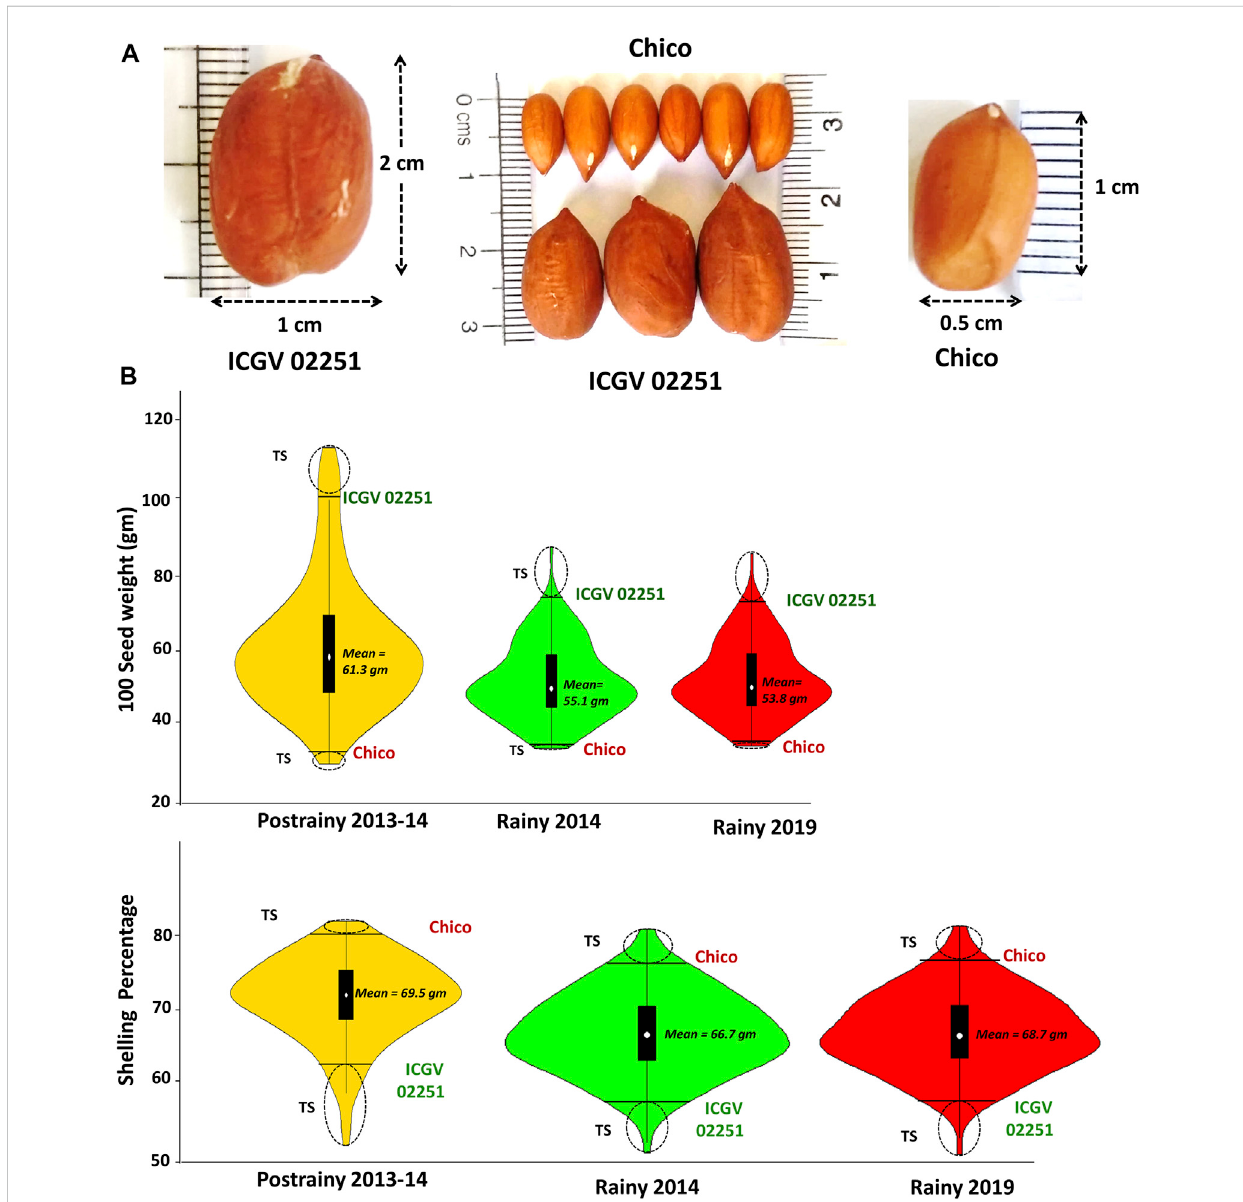
FIGURE 1 Variation in the phenotypic data generated for (A) hundred seed weight and (B) shelling percentage in the RIL population (Chico × ICGV 02251) during three seasons (Postrainy 2013-14, Rainy 2014 and Rainy